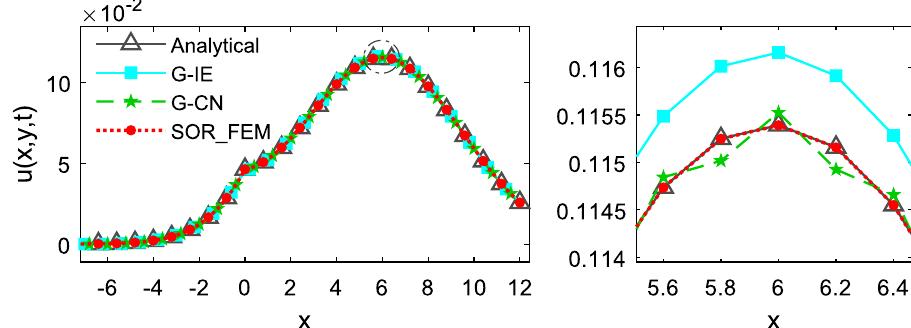
Figure 9. Temperature along the line y = 0.5 at time t = 1.2.